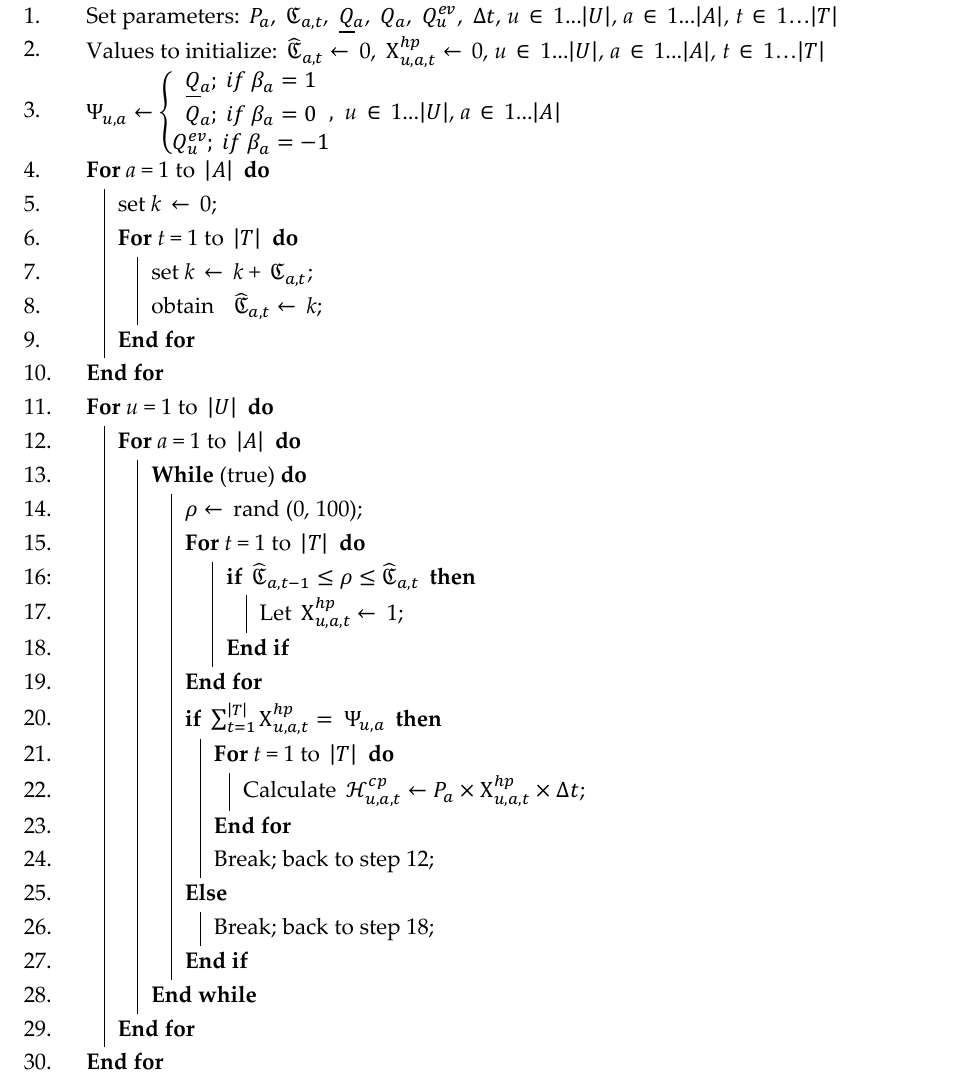
Algorithm 1. Simulation of uncertainties in household appliances usage.